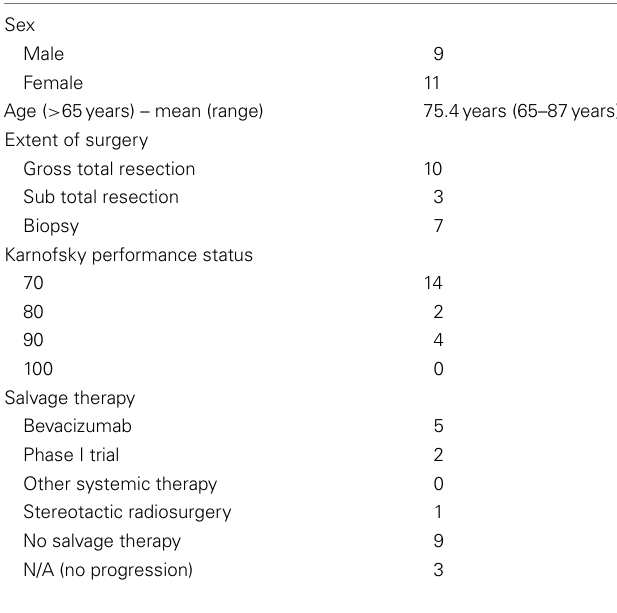
Table 1 | Patient and treatment